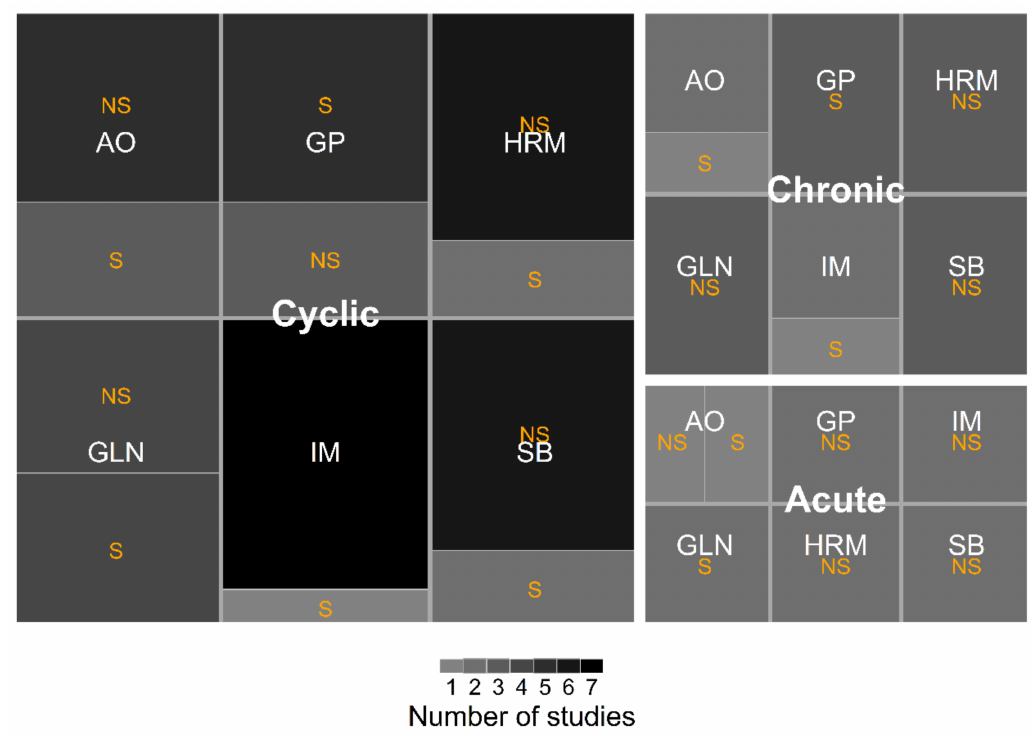
Figure 3. Treemap of outcomes evaluated from selected studies in the meta-analysis. The labels “Cyclic”, “Chronic” and “Acute”, are the different categories of HS applied in a study. The two or three-letter abbreviations correspond to a category of outcomes. The shade of gray refers to the number of reports that did or did not study a particular outcome in their trials. Abbreviations: AO: antioxidant parameters; GLN: dietary glutamine concentration; GP: growth performances; HRM: hormones; IM: intestinal morphology; NS: not studied; S: studied; SB: serum biochemicals.